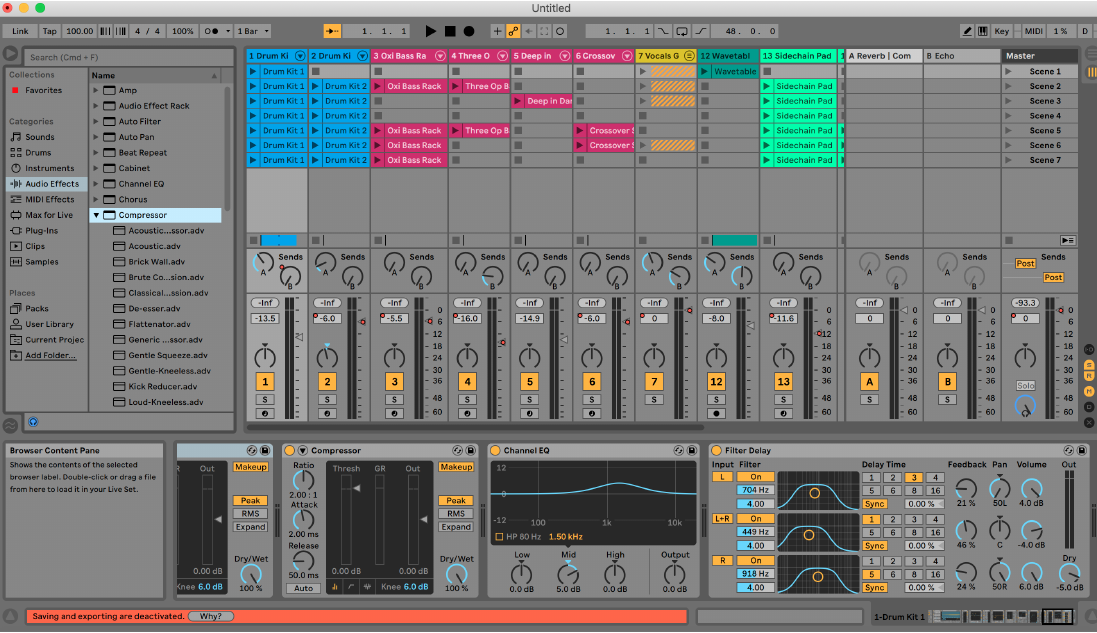
Figure 2. Ableton Live 10, the current version as of the writing of this article. Screen capture created by the